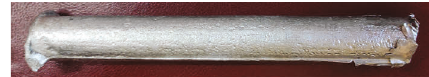
Figure 2: Al7075–TiC composites after casting.